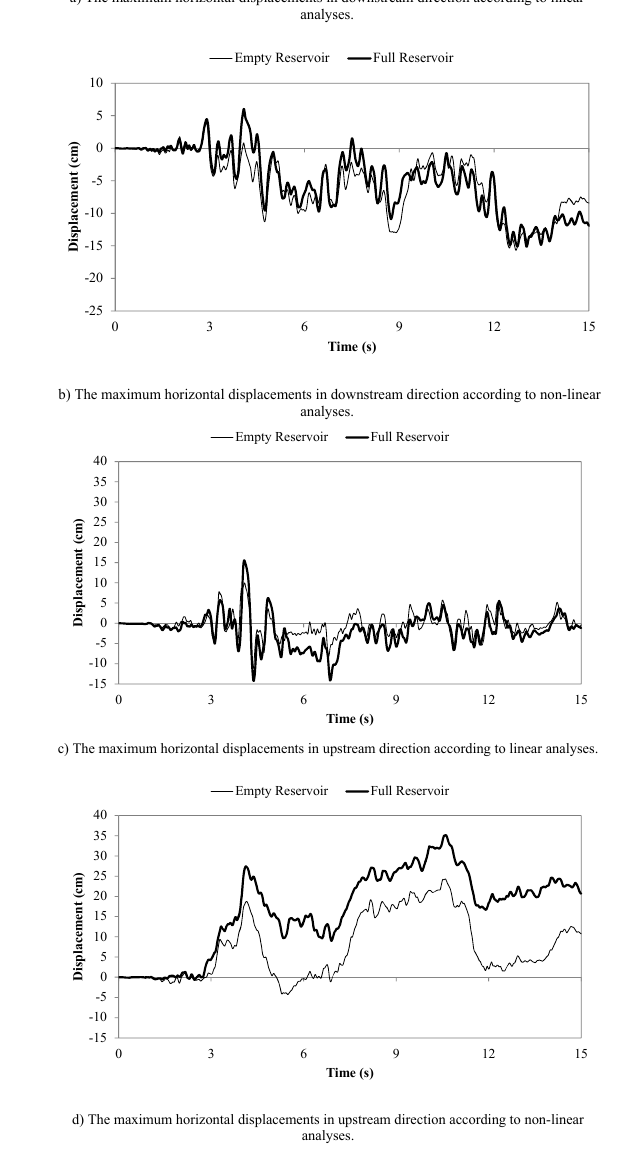
Fig. 18. The maximum horizontal displacements during earthquake.